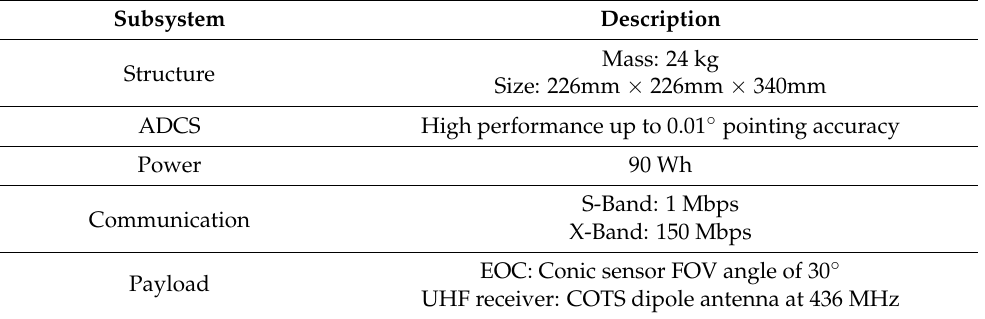
Table 1. High-level 12U CubeSat system specifications.